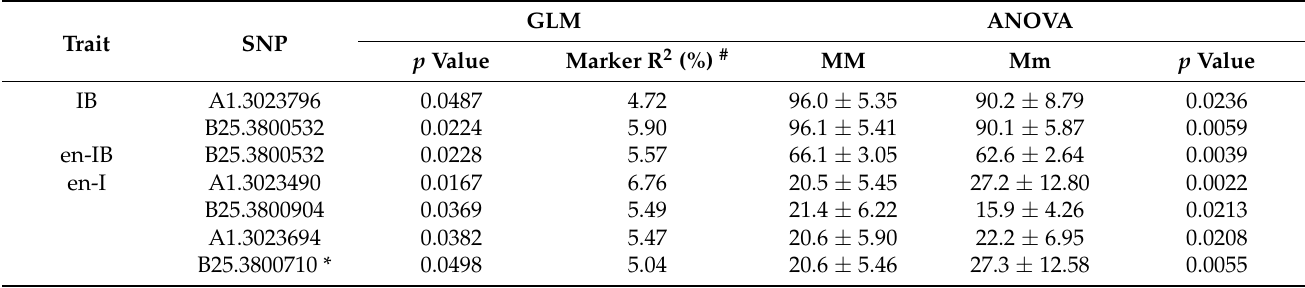
Table 3. Association analysis of IB numbers using GLM and